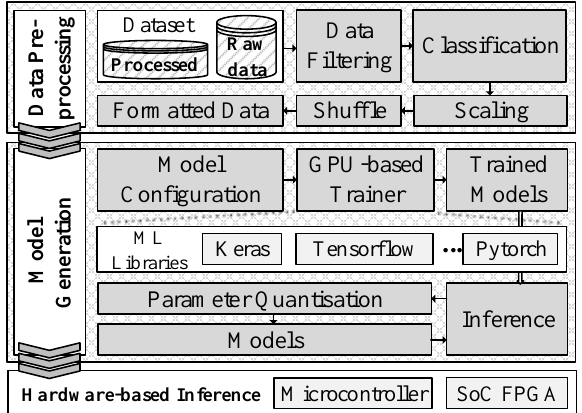
Figure 1. The proposed HH-NIDS framework